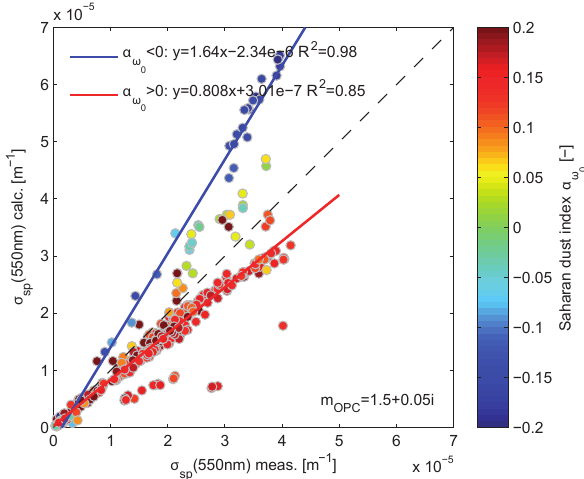
Fig. 3. Calculated vs. measured aerosol light scattering coefficient (dry, at λ = 550nm and a refractive index for the OPC correction of m OPC = 1 . 5 + 0 . 05i as an example). The color code denotes the ˚Angstr¨om exponent of the single scattering albedo α ω used to identify mineral dust at Jungfraujoch (also called Saharan dust index). Data affected by mineral dust (negative values of α ω and non-affected data points (positive values of α ω arately with a linear least squares regression (solid lines). The black dashed curve represents the 1:1